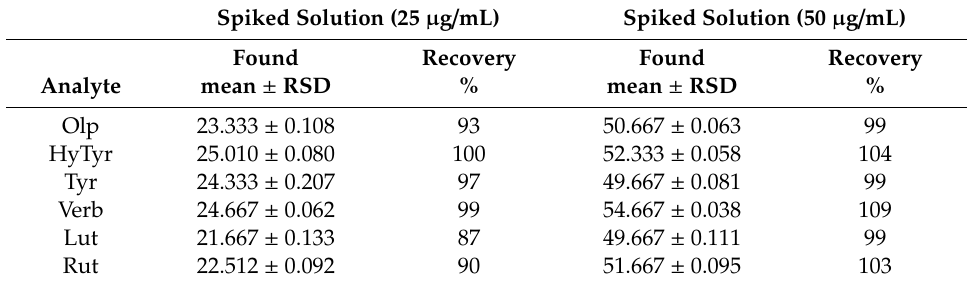
Table 1. Results from recovery tests of spike solutions at 25 and 50 µ g / mL. Data are expressed as the means ± relative standard deviation (RSD) of three independent observations. Olp: oleuropein; HyTyr: hydroxytyrosol; Tyr: tyrosol; Ver: verbascoside; Lut: lutein; Rut: rutin. Spiked Solution (25 µ g / mL) Spiked Solution (50 µ g / mL) Found Recovery Found Recovery Analyte mean ±